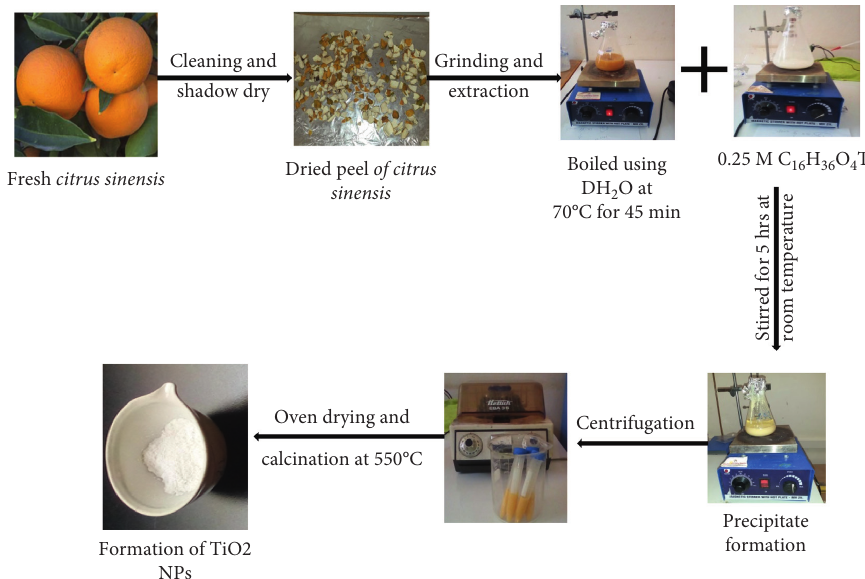
Figure 1: Schematic green synthesis procedure of TiO 2 (1 :1) NPs in the presence of Citrus sinensis peel extract.